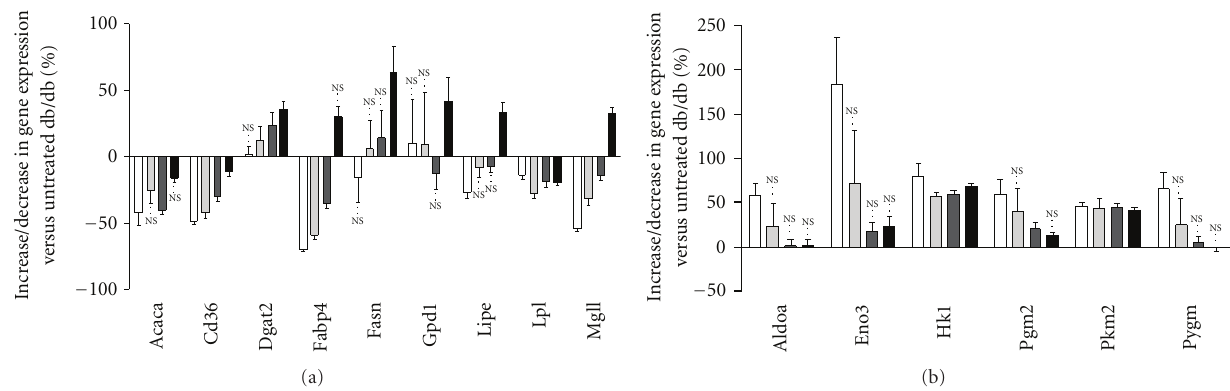
Figure 6: Expression profiles of key genes involved in Soleus muscle glucose and lipid metabolism. Di ff erentially expressed genes in db/+ (the white square) and 10 (the o ff -white square), 30 (the grey square), and 100 (the black square) mg/kg RSG-treated db/db mice were measured versus untreated db/db and plotted as the mean (% increase/decrease of db/db control) ± SEM ( n = 6). NS; P ≥ . 001 otherwise P < . 001. (a) Genes related to glucose metabolism ∗ : Eno3, enolase 3, beta muscle; Hk1, hexokinase 1; Pkm2, pyruvate kinase, muscle; Pgm2, phosphoglucomutase 2; Pygm, muscle glycogen phosphorylase. (b) Genes related to lipid metabolism: Dgat2, diacylglycerol O- acyltransferase 2; Lipe, lipase hormone sensitive; ∗ gene abbreviations given in Figures 1, and 4 were not